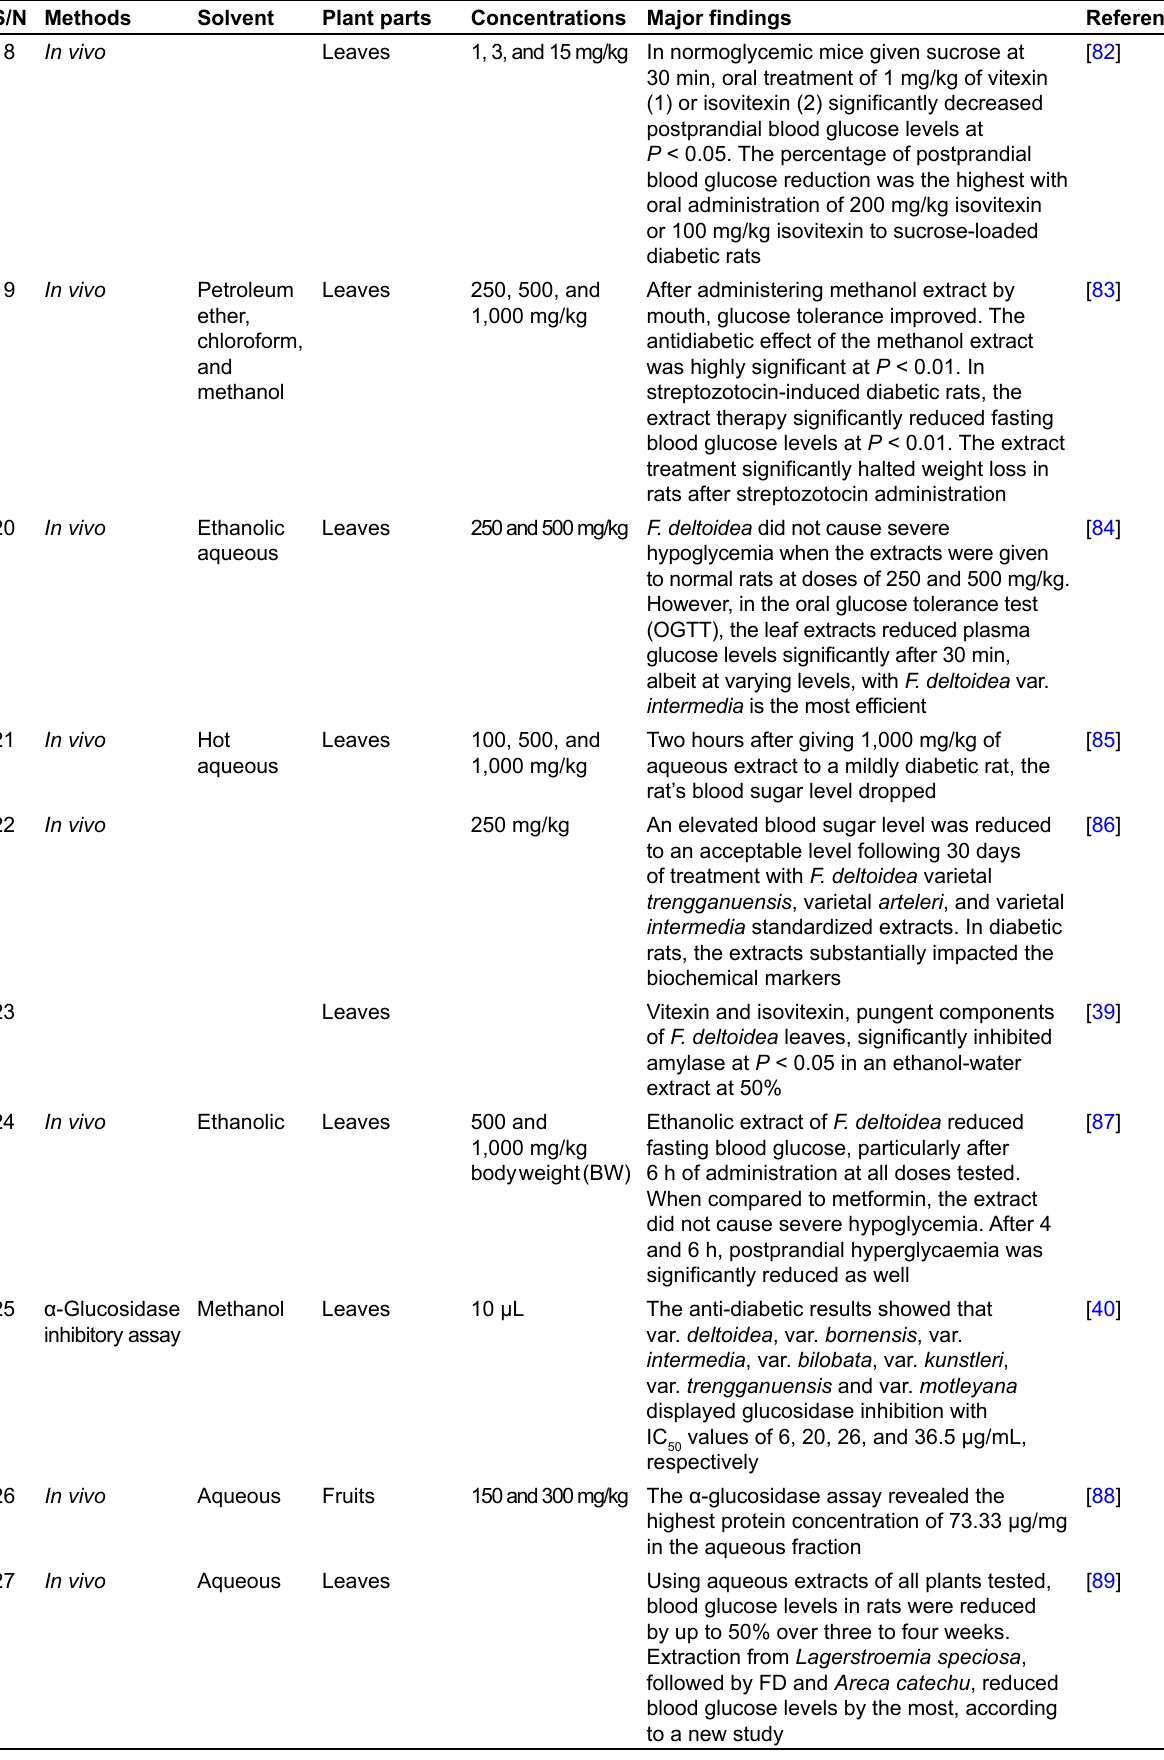
Table 4. FD effects on the endocrine system ( continued ) S/N